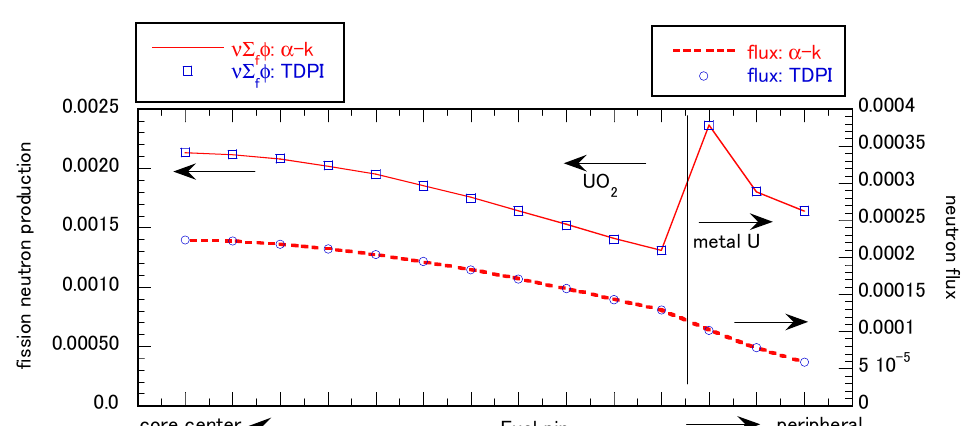
Figure 4. Comparison of spatial distributions of flux and fission neutron emission by α - k and TDPI.